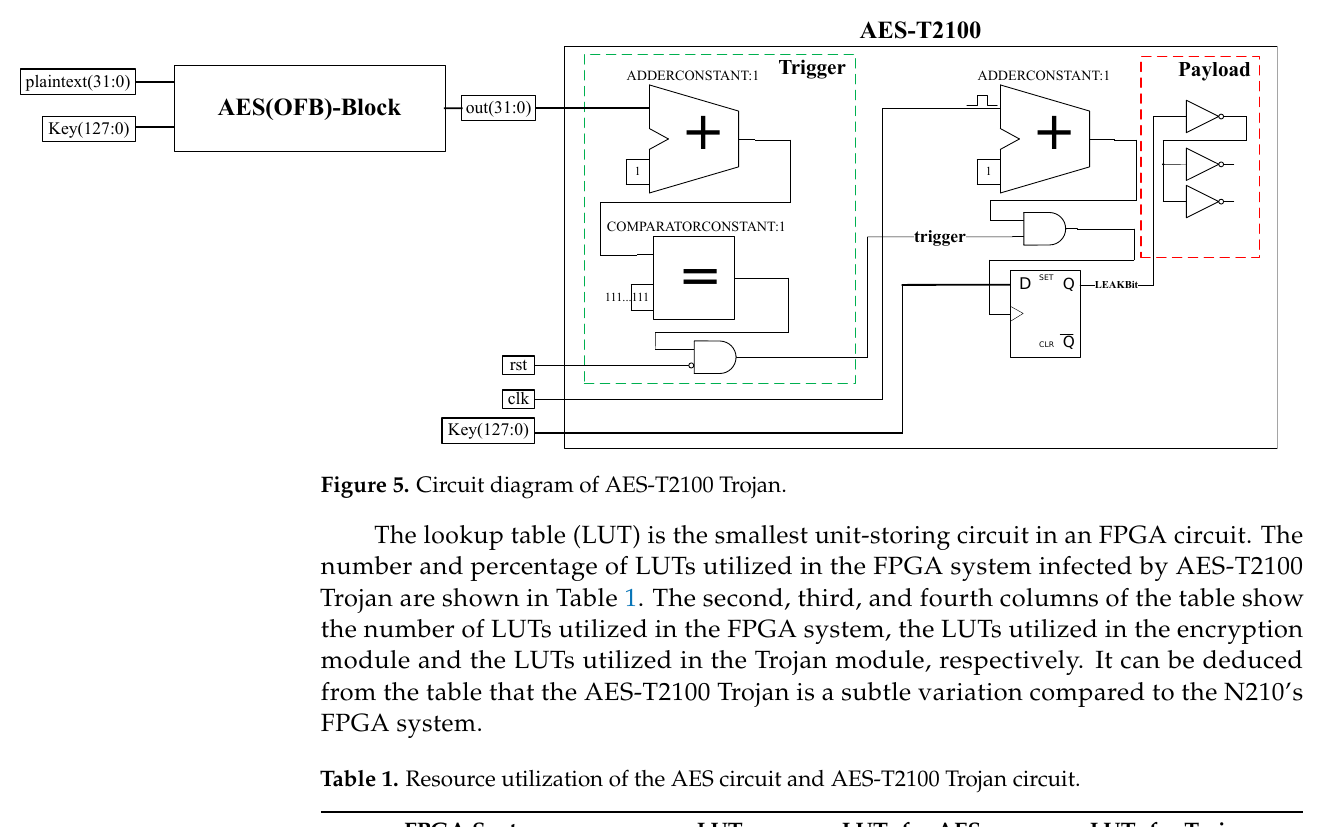
Table 1. Resource utilization of the AES circuit and AES-T2100 Trojan circuit. FPGA Syetem LUTs LUTs for AES LUTs for Trojan Transmitter with AES-T2100 32883 129 (0.392%) 103